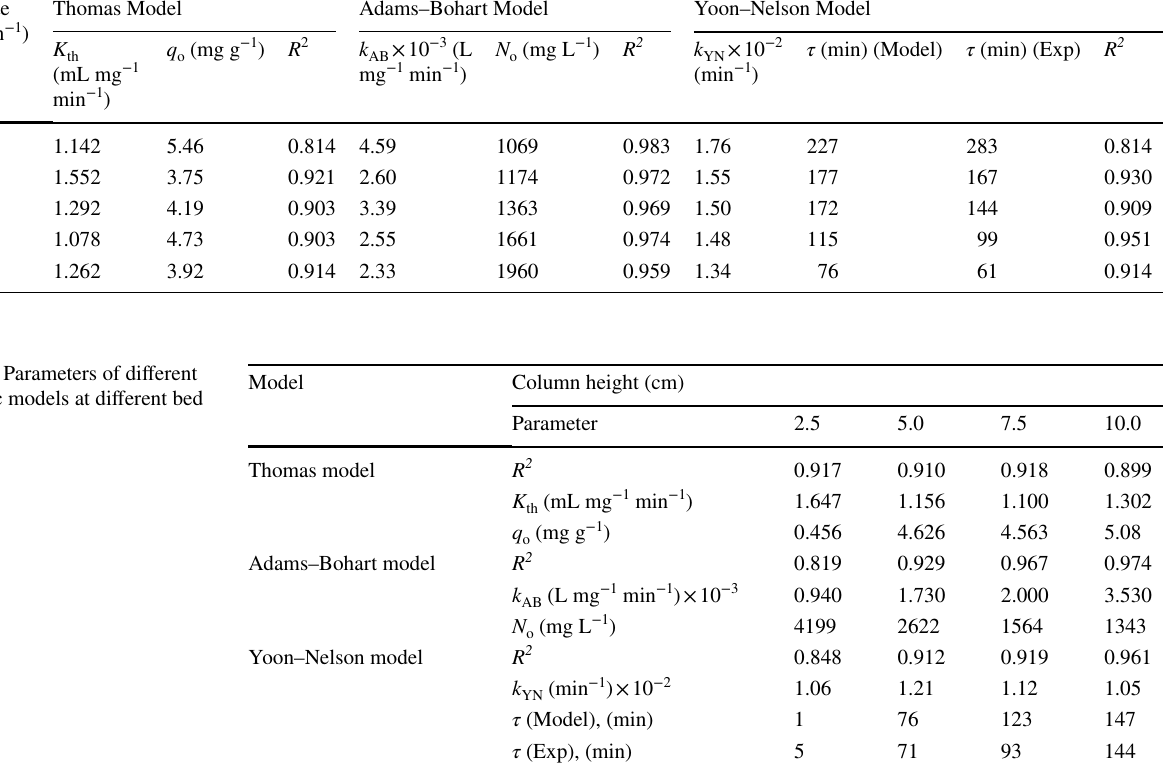
Table 3 Parameters determined from linearized dynamic models at different flow rates Flow rate Thomas Model Adams–Bohart Model (mL min −1 )